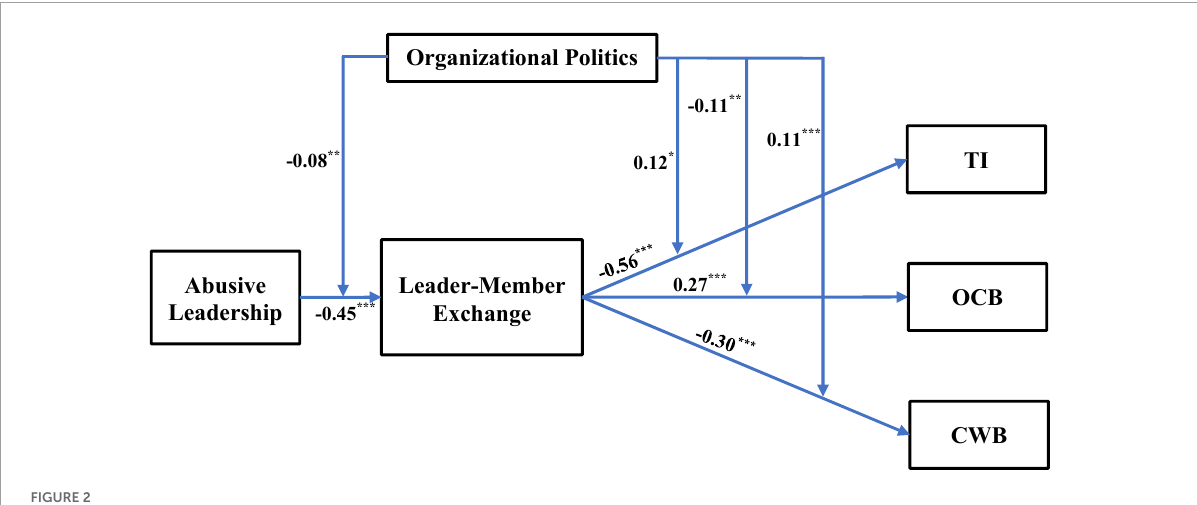
FIGURE2 Path diagram and unstandardized regression coefficients. * p < 0.05, ** p < 0.01, *** p < 0.001. TI, turnover intentions; OCB, organizational citizenship behavior; CWB, counterproductive work